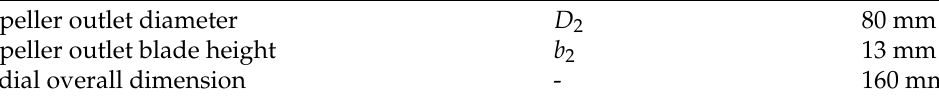
Table 2. Maximum value for some pump geometric parameters prescribed by packaging